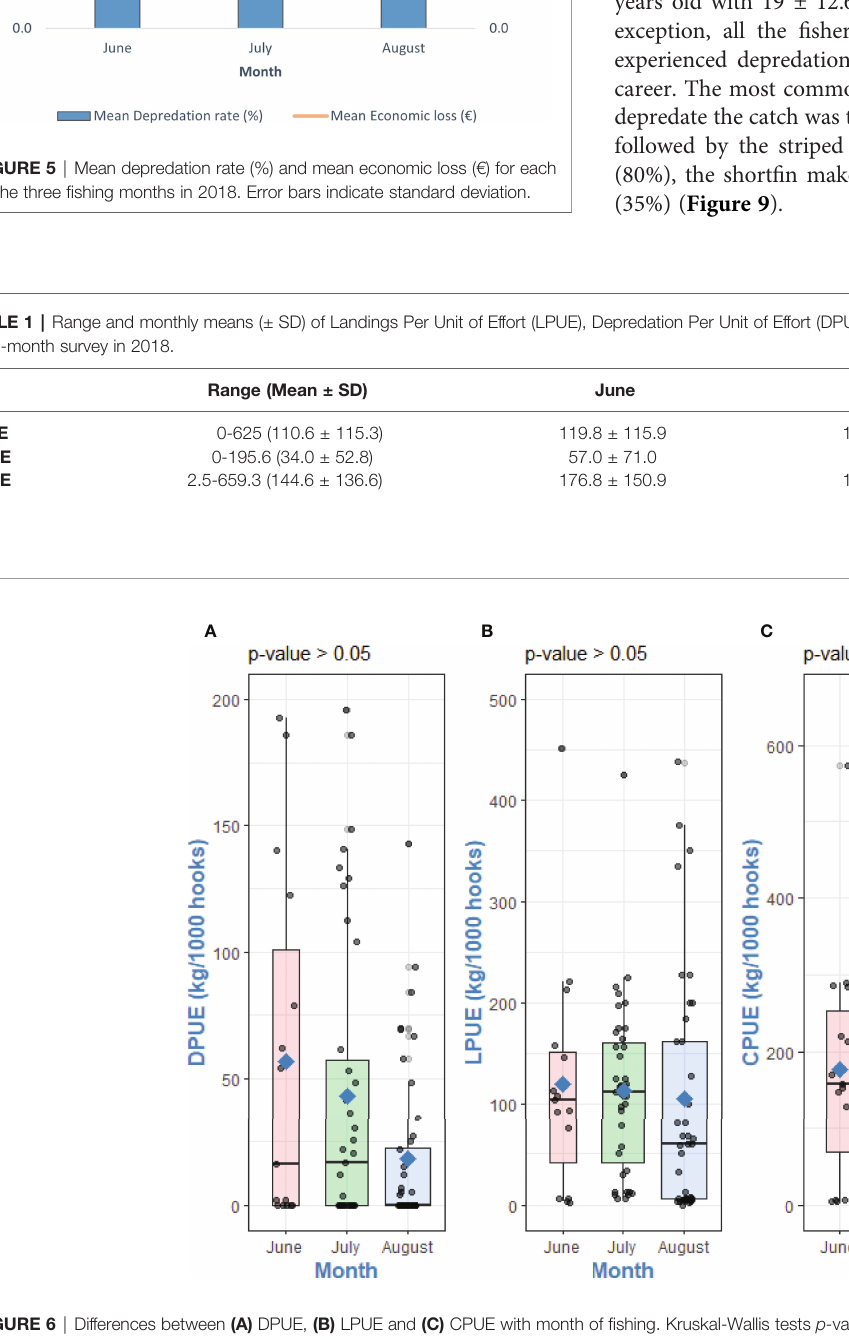
FIGURE 6 | Differences between (A) DPUE, (B) LPUE and (C) CPUE with month of fi shing. Kruskal-Wallis tests p- values. Points are raw survey data. Rhombuses represent the mean of each